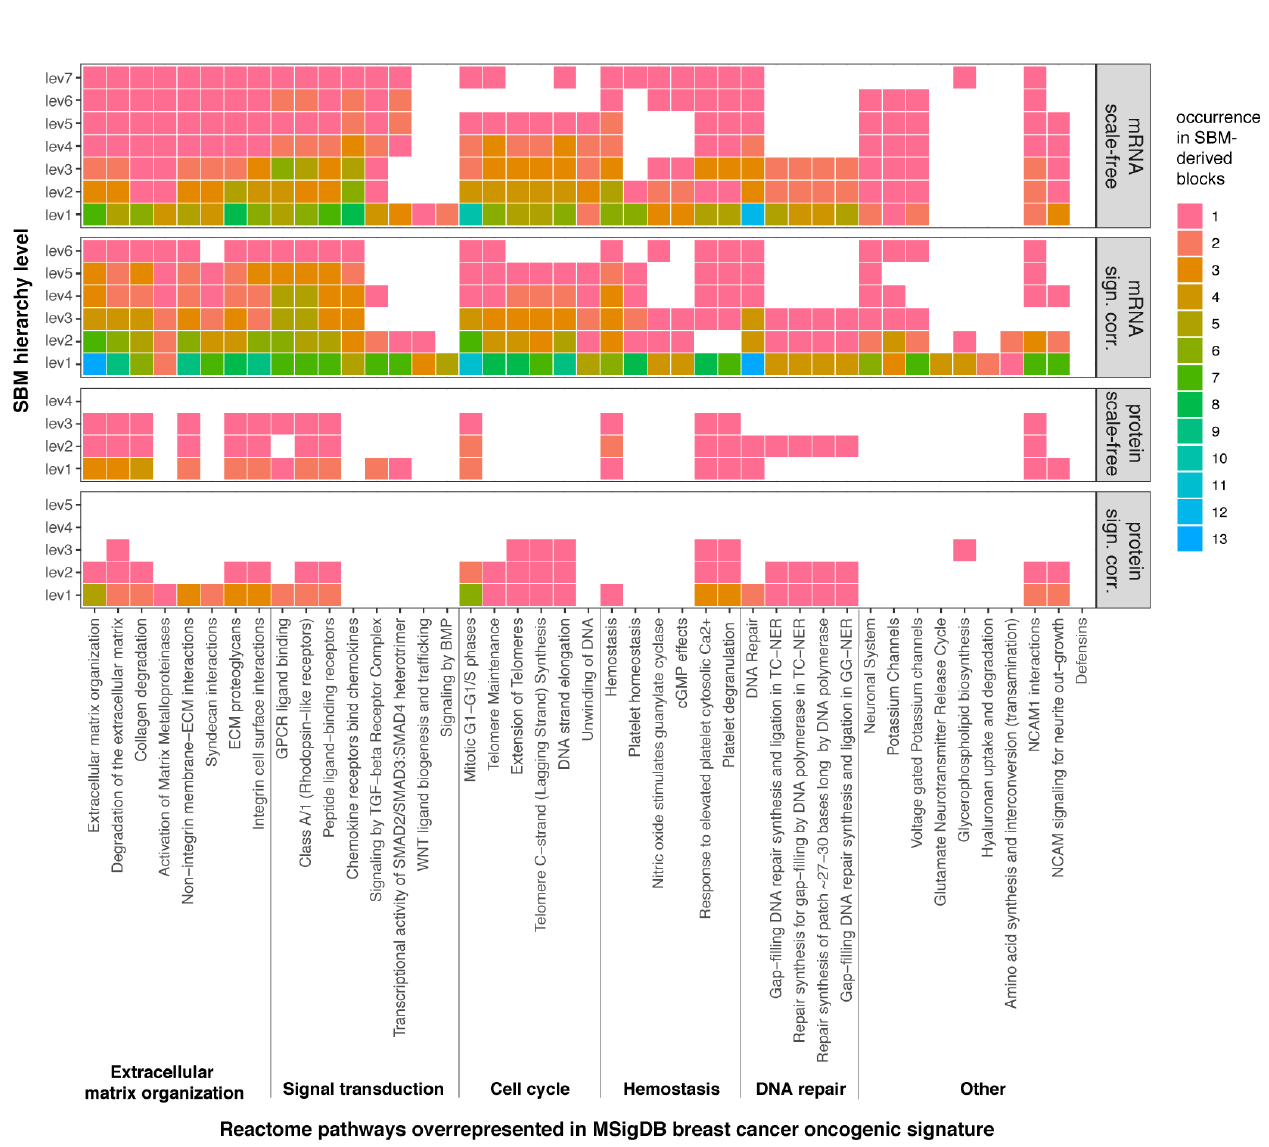
Figure 4. SBM-derived blocks of mRNA and protein networks exhibit biological functions related to breast cancer signature. Oncogenic signature gene sets related to breast cancer were retrieved from MSigDB 42 and mapped to Reactome pathways. The color code shows for how many SBM-derived blocks each of these pathways was overrepresented, for the four mRNA and protein networks and each hierarchy level. Hierarchy levels without any blocks with overrepresented pathways are